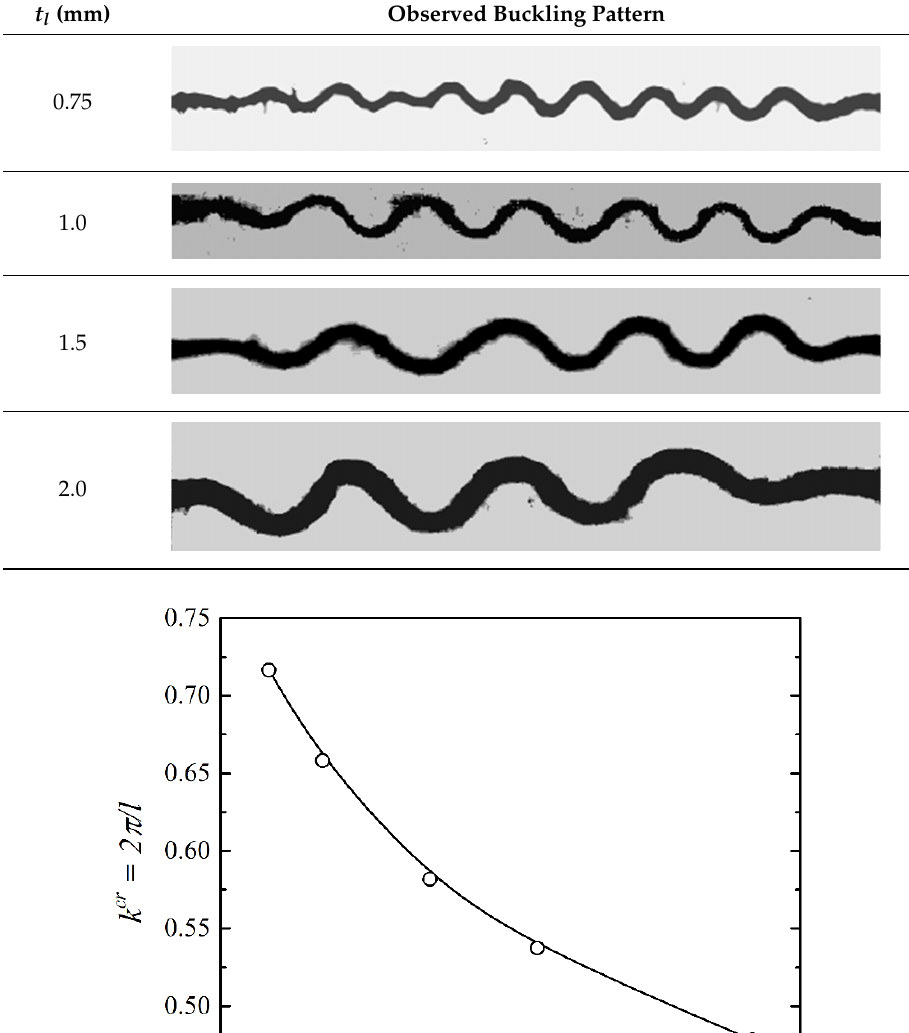
Table A1. Observed buckling patterns for the samples with different thickness of the stiff layer t l .